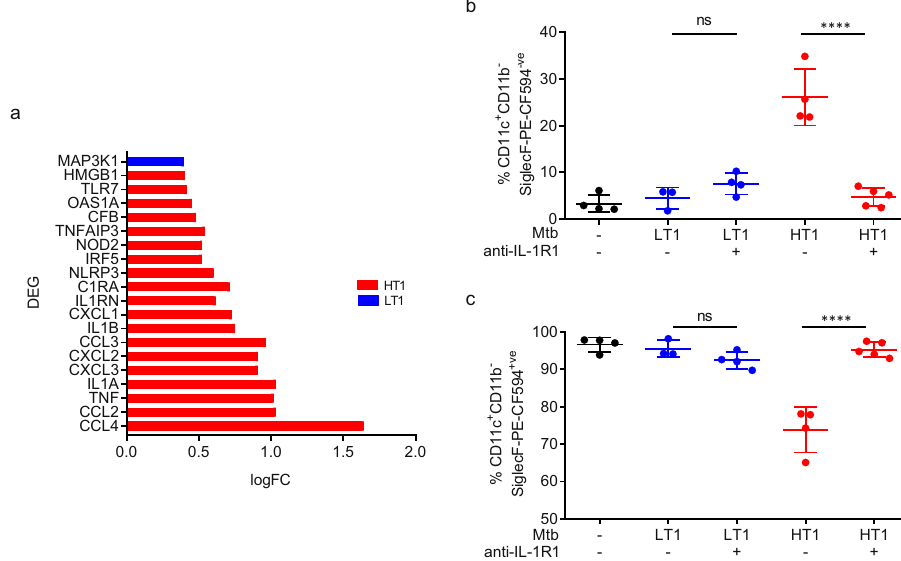
Fig. 6 IL-1R dependent migration of alveolar macrophages in Mtb-HT infection. C3HeB/FeJ mice were infected with ~100 CFU of Mtb-LT1 or Mtb-HT1 via Glas-Col aerosol exposure. At 13 days post infection, fl uorescent-labeled anti-SiglecF antibody was intratracheally administered 30 min prior to sacri fi ce to stain and sort airway resident cells. Differential gene expression analysis by NanoString was performed on airway-resident AMs (CD11b-CD11c + SiglecF + ) sorted from single cell lung suspensions pooled from fi ve Mtb-HT1 and fi ve Mtb-LT1 infected mice and the data are presented to show log fold change (logFC) of top DEG ( Y -axis, P < 0.05) ( a ). For IL-1R dependent AM migration, groups of infected mice were administered intra-peritoneally on days 8, 10, and 12 post infection with either 200 μ g α -IL-1R1 antibody or isotype control. Data are presented as airway-resident AMs (CD11b-CD11c + SiglecF + ) ( b ) and AMs migrated into the interstitium (CD11b-CD11c + SiglecF − ) ( c ). Data are presented as mean values + / − SD (panels b and c). Source data are provided as a Source Data fi le. Sample size of n = 4 mice were included for the fi rst 4 groups and sample size of n = 5 mice for group 5 for panels ( b , c ). Signi fi cance was determined using one-way ANOVA with Tukey ’ s correction. **** P < 0.0001. The data are representative of one of two individual experiments with Mtb-HT1 and Mtb-LT1 and was repeated with Mtb-HT2 and